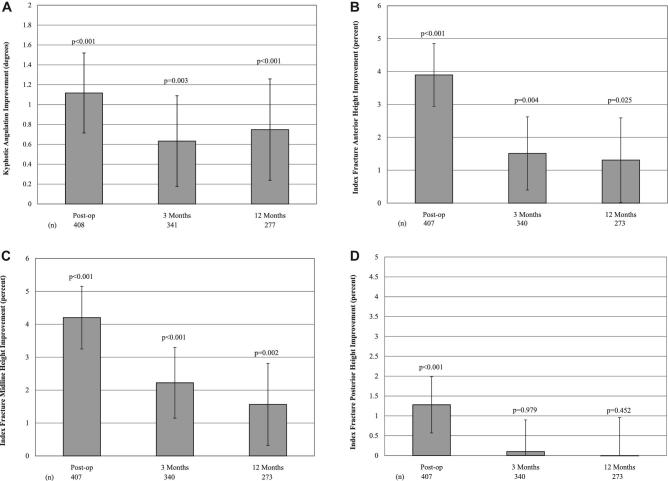
Index vertebral body kyphotic angulation correction and height restoration. Means and 95% CIs are shown for A, kyphotic angulation of index fractures; B, index fracture anterior height as a percent; C, index fracture midvertebral height as a percent; D, index fracture posterior height as a percent. p-values for change from baseline improvement are shown for each time point. Below each panel, the n for each group is shown for baseline, 3, and 12 mo.